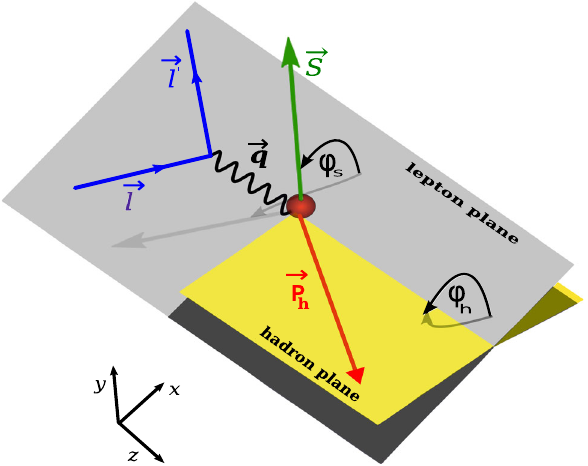
Fig. 1 Definitionofazimuthalangles( φ s , φ h ),leptonandhadronscat- tering planes in semi-inclusive deep inelastic